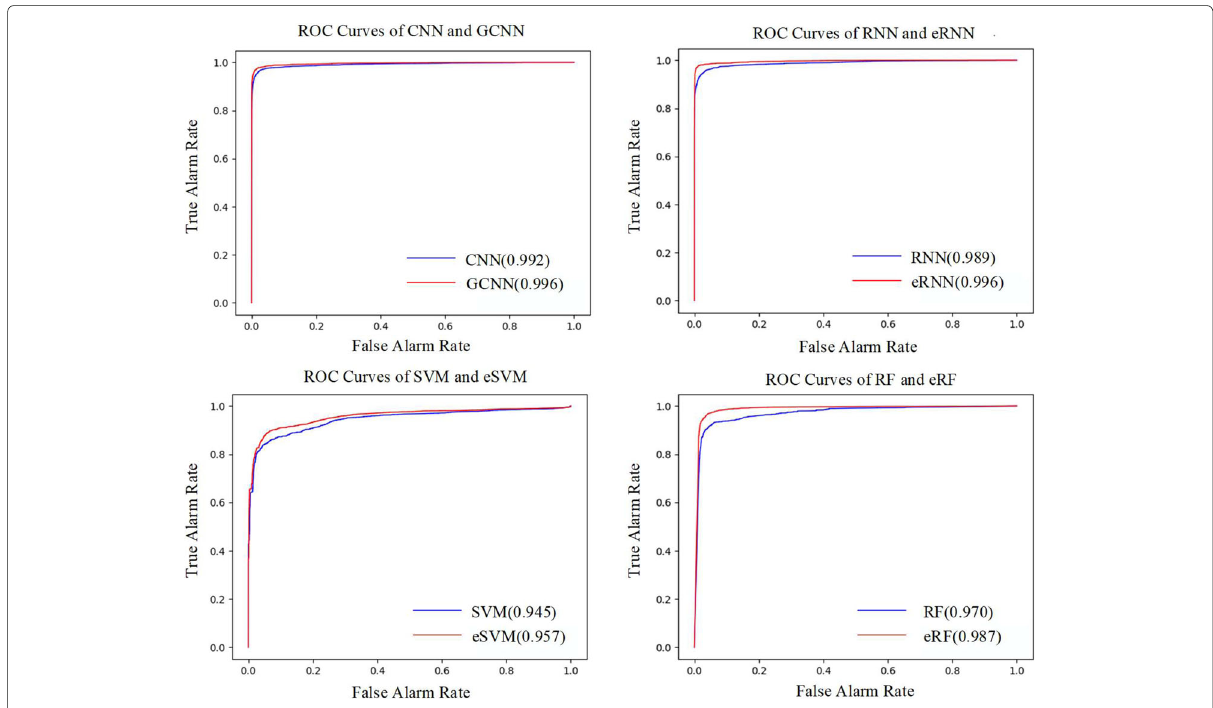
Fig. 6 The process of crafting training set and test set